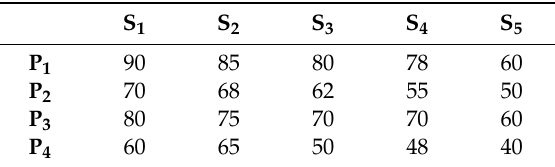
Table 1. Tons of each